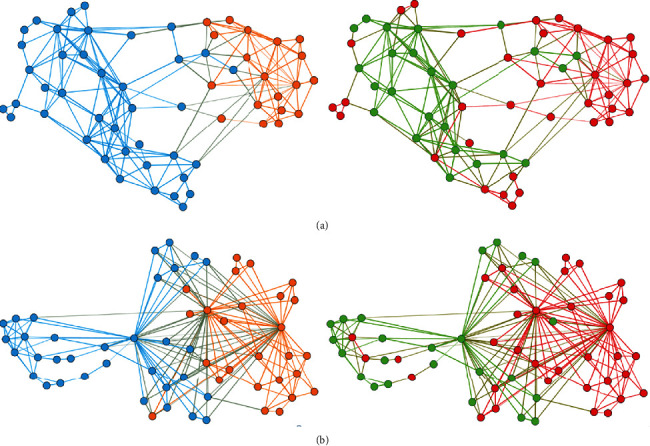
Patient similarity networks for the combination of chemokine expression (% of CXCR3, and MFI of CXCR4, CXCR5, CCR7) on (a) CD5high and (b) CD5low subpopulations in CLL patients. The nodes represent individual CLL patients, the lines connect the patients with high similarity in chemokine profiles. IgHVmut patients are presented in green, IgHVunmut patients in red. CXCR3 positive cells with cut-off <65% for CD5high and <24% for CD5low, respectively, are orange, and CXCR3 positive cells with cut-off >65% for CD5high and >24% for CD5low are blue.